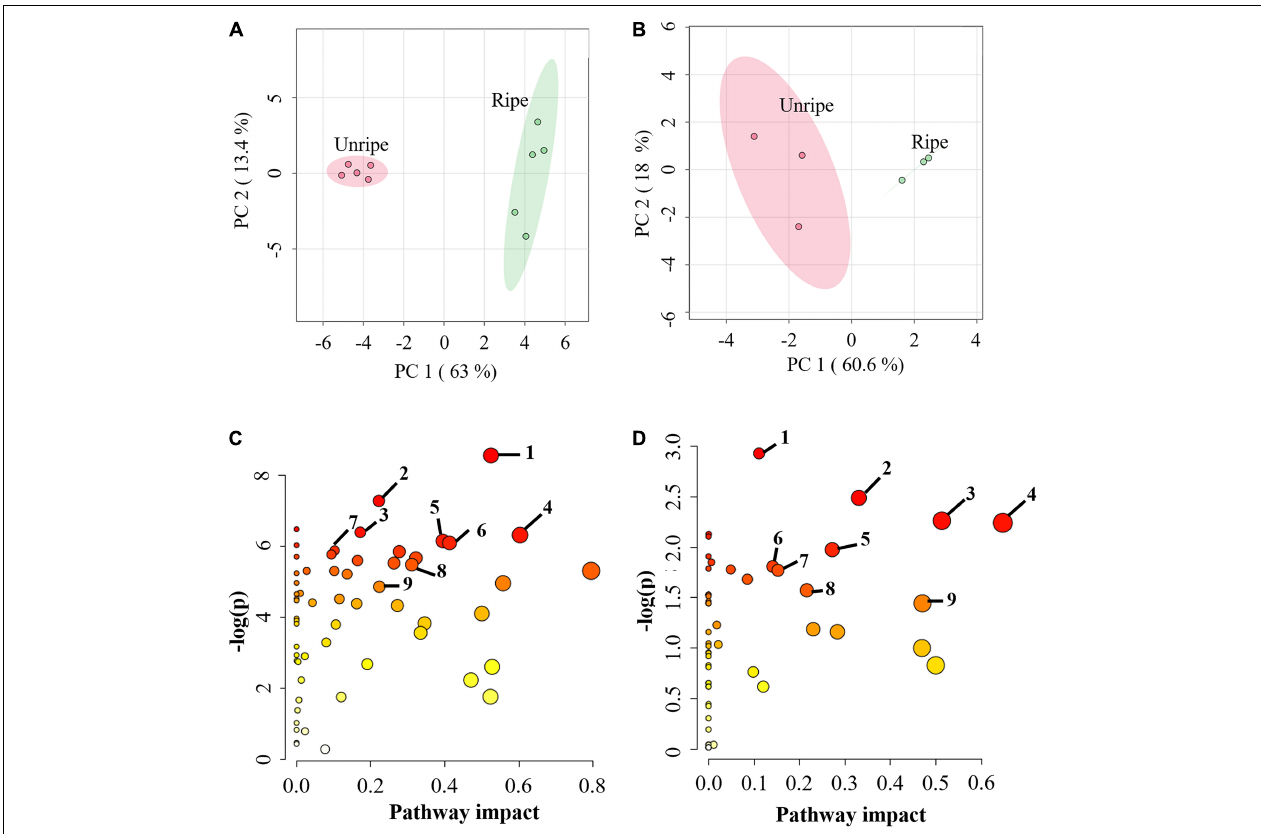
FIGURE 1 | (A) Principal component analysis (PCA) score plot of metabolites from capillary electrophoresis-time of flight/mass spectrometry (CE-TOF/MS) and (B) from gas chromatography- time-of-flight mass spectrometry (GC-TOF/MS) in the pulp of durian cv. Monthong at unripe and ripe stages, which are labeled in red and green, respectively. Each dot represents each biological replicate sample, and the circle represents 95% confidence intervals. (C) Metabolic pathway analysis (MetPA) of metabolites from CE-TOF/MS and (D) from GC-TOF/MS. Matched pathways related to ripening of durian cv. Monthong are displayed as circles. The color and size of the circles represent the P value and pathway impact value, respectively. The significantly altered pathways associated with our detected primary metabolites were labeled. Metabolic pathways with pathway impact > 0.1 and P < 0.05 were perturbed pathways. The top 7 perturbed pathways of (C) are as follows: 1, arginine and proline metabolism; 2, aminoacyl-tRNA biosynthesis; 3, glutathione metabolism; 4, glycine, serine and threonine metabolism; 5, cysteine and methionine metabolism; 6, glyoxylate and dicarboxylate metabolism; 7, vitamin B6 metabolism. The central carbon pathways of (C) are: 8, Citrate cycle (TCA cycle); 9, glycolysis. All perturbed pathways of (D) are: 1, aminoacyl-tRNA biosynthesis; 2, starch and sucrose metabolism; 3, glycine, serine and threonine metabolism; 4, alanine, aspartate and glutamate metabolism; 5, galactose metabolism; 6, glutathione metabolism; 7, arginine and proline metabolism; 8, tyrosine metabolism; 9, phenylalanine